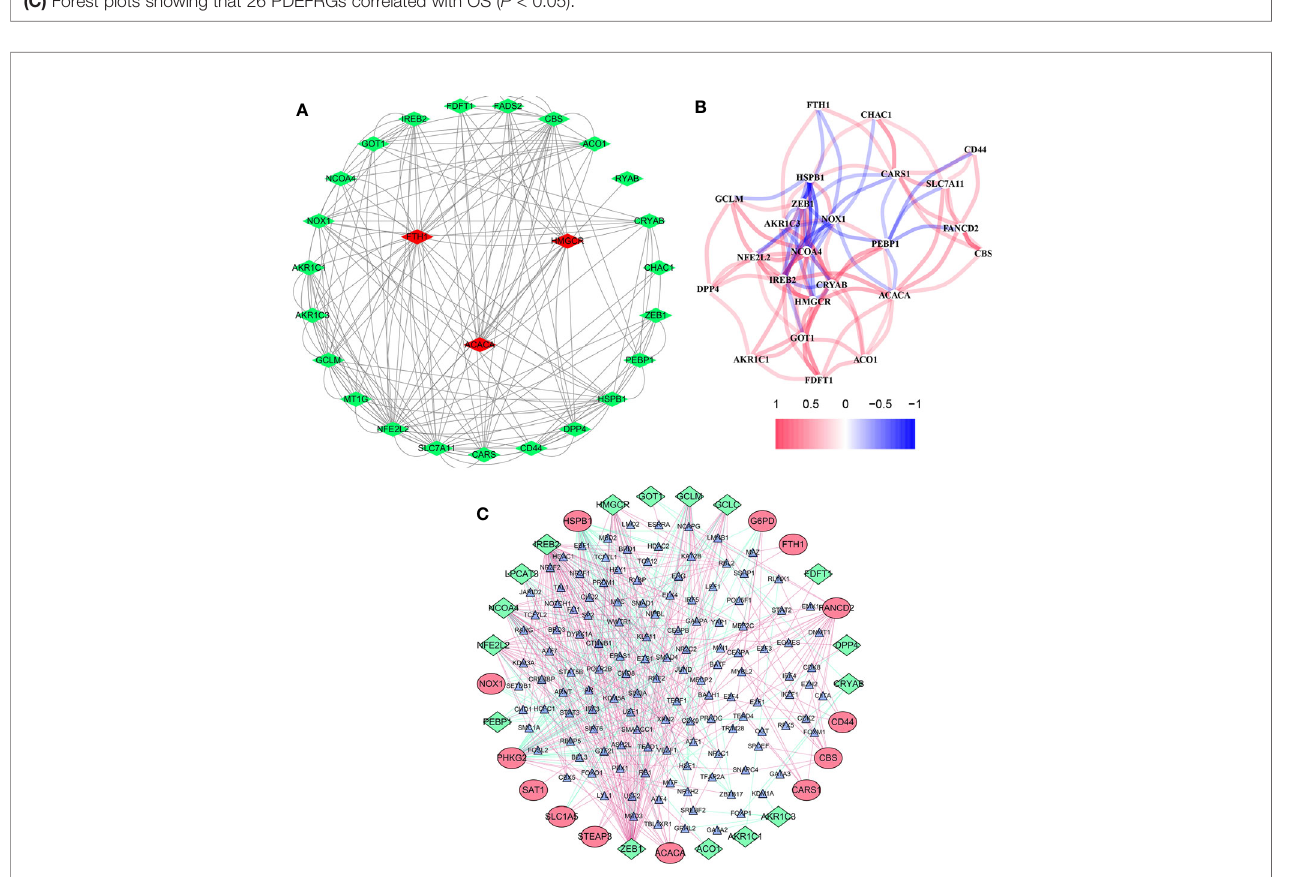
FIGURE 3 | Network of FRGs. (A) PPI network constructed with the nodes with interaction con fi dence value >0.15 of 26 PDEFRGs. (B) The correlation network of 26 PDEFRGs. Different colors represent the correlation coef fi cients. (C) TFs-FRGs network; the green nodes: FRGs with low risk ( P < 0.05), the red nodes: FRGs with high risk ( P < 0.05), the blue nodes: TFs that correlated with the FRGs (correlation coef fi cient >0.4).